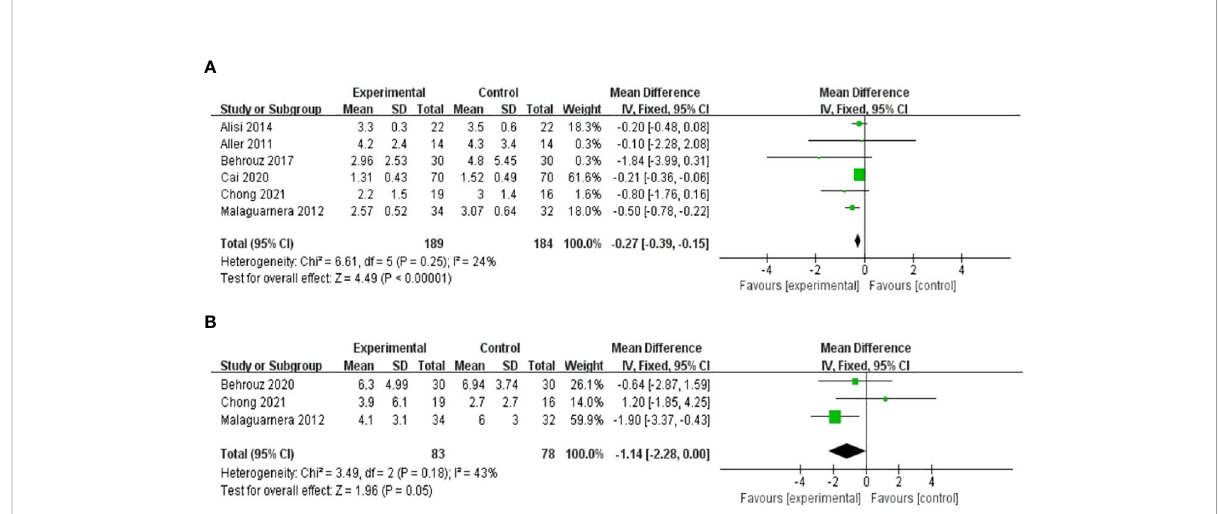
FIGURE 7 Forest plot of the effect of probiotic supplementation on HOMA-IR in studies with a duration of more than 8 weeks (A) . Forest plot of the effect of probiotic supplementation on CRP (B)